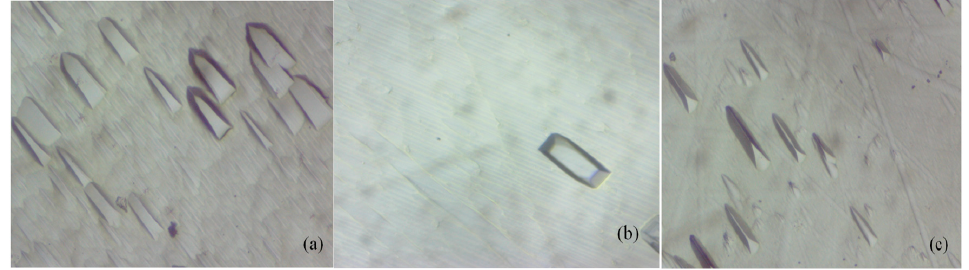
Figure 2. Dislocation etching pit patterns of Tm,Ho:GdYTaO 4 crystal at three different crystalline faces: ( a ) (100); ( b ) (010); and ( c ) (001).